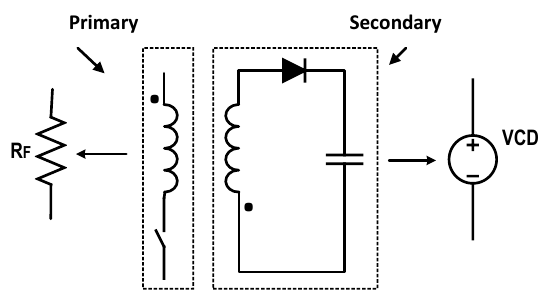
Figure 2. Flyback model in DCM for the LFAA.